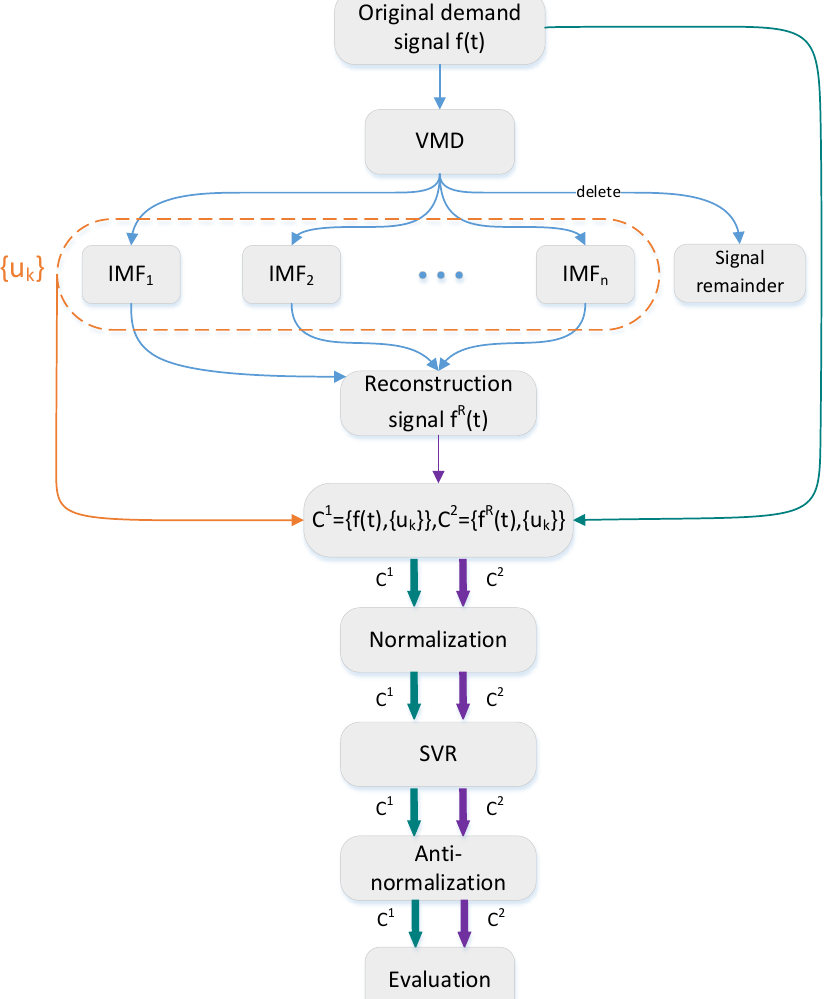
Figure 2. Flow chart of demand forecast.